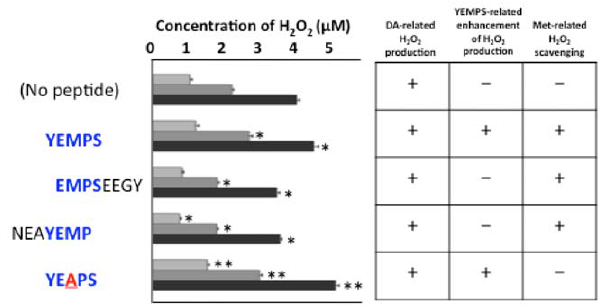
Figure 6. Concentrations of H 2 O 2 produced by DA alone and with various peptides from the C-terminal sequence of a -syn 15 min (light gray), 30 min (dark gray), and 60 min (black) after incubation. DA alone (no peptide) produced increasing amounts of H 2 O 2 over time. Co-incubation of DA with the YEMPS peptide enhanced H 2 O 2 production, while the Y127- (EMPSEEGY) and S129- (NEAYEMP) lacking peptides produced less H 2 O 2 than DA alone or with the YEMPS peptide. Moreover, co-incubation of DA with the methionine-mutated peptide (YEAPS) produced the highest amounts of H 2 O 2 among all conditions. *p , 0.01 vs. no peptide, **p , 0.01 vs. no peptide and YEMPS (ANOVA).